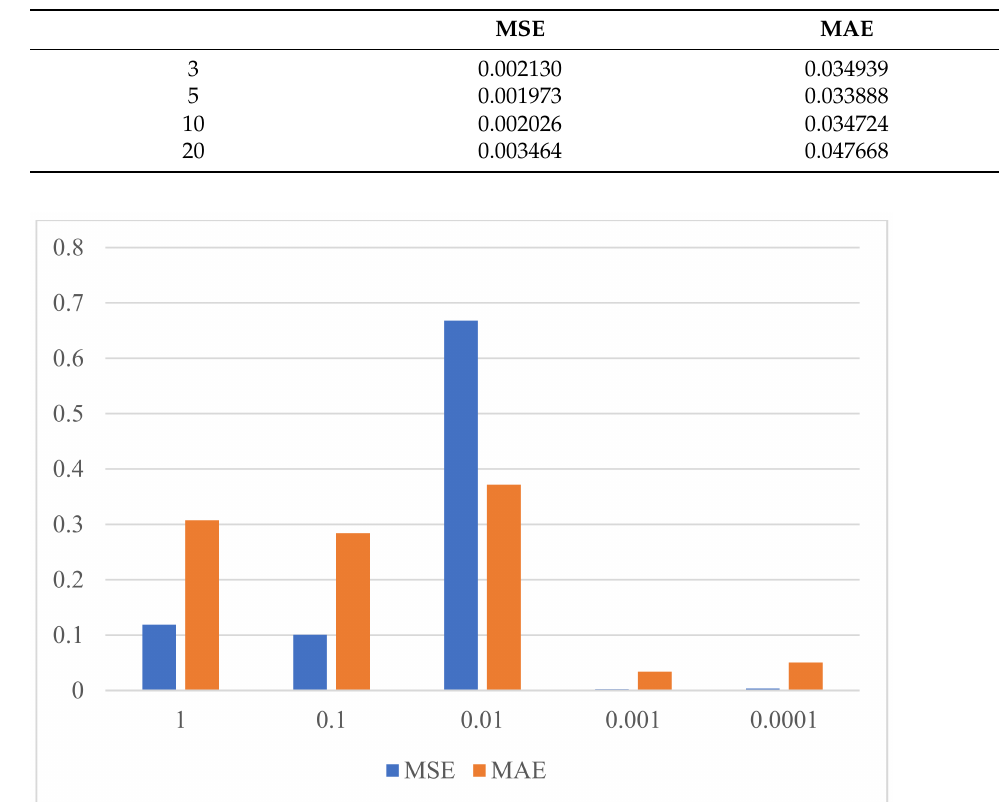
Figure 5. Performance of the WT_TDLSTM model with different learning rates on the residential monthly electricity price